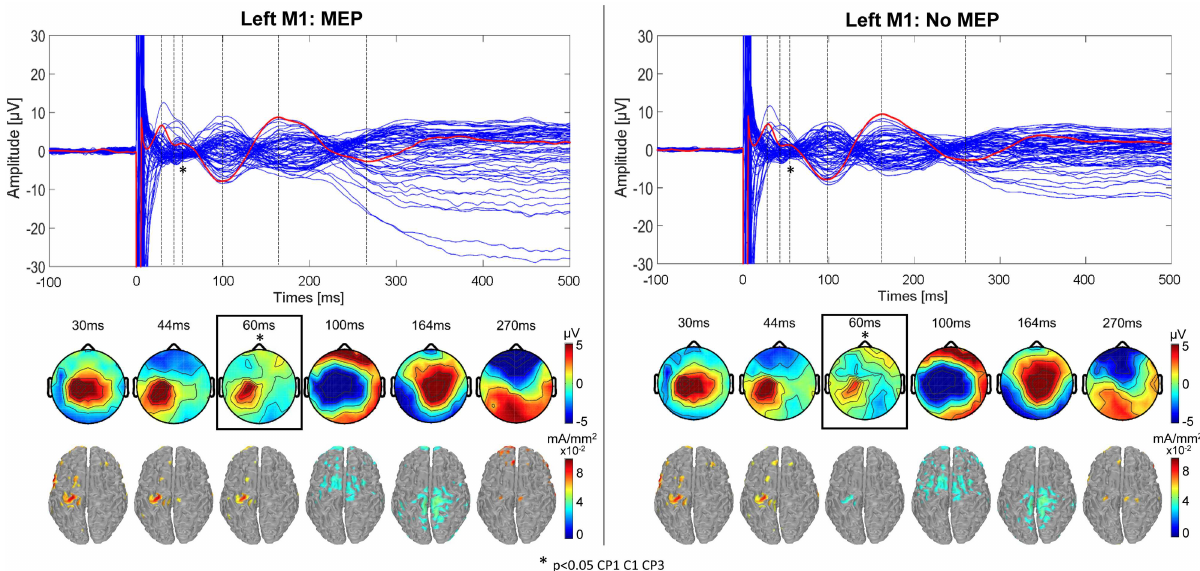
Fig 3. TEPs for left M1 stimulation for MEP and no-MEP trials. (Upper) Butterfly plot of the averageTMS-evoked activity from all electrodes(average of 11 participantswith simultaneous EMG recording)for trials with an MEP (left) and those without (right). Red line indicatesCz electrode. Timing of the peaks is indicatedby vertical dashed lines. (Lower) Voltage distributions and cortical current density estimates of the TMS-evoked activity for each peak in the Cz waveform. The blue boxes and asterisks highlight the 60ms latency, for which the topographysignificantly differed betweenthe MEP and no-MEP conditionsfor electrodesCP1, C1, and CP3 ( p < 0 . 05 ).